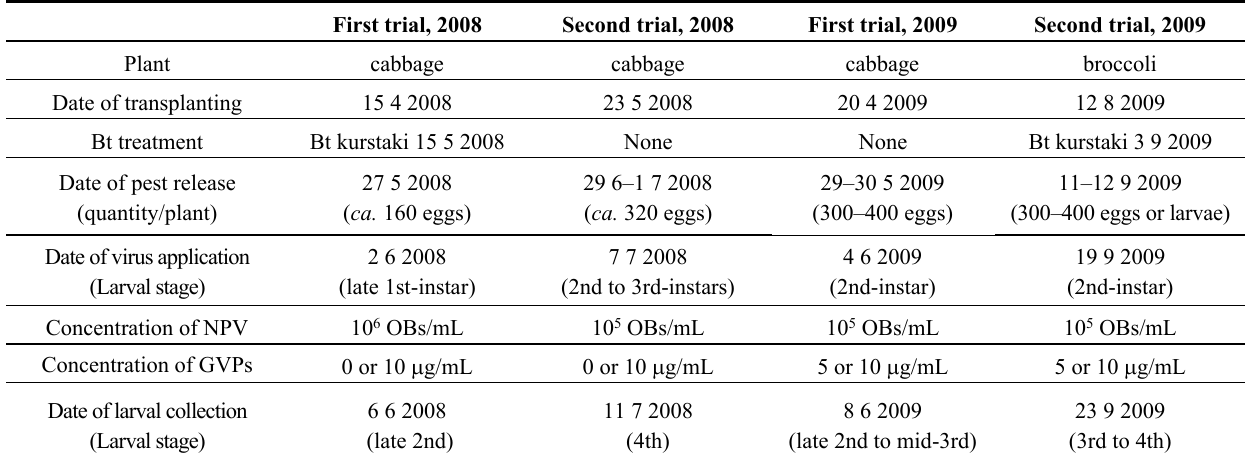
Table 1. Details of the field trials in 2008 and